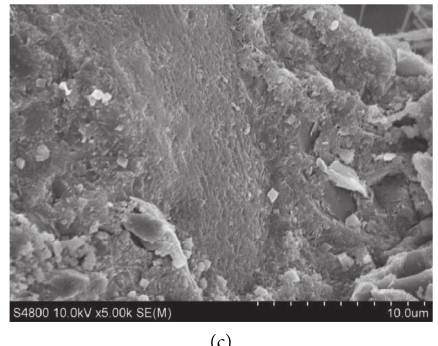
Figure 6: SEM of HPC with different mineral admixtures. (a) Fly ash; (b) CFBC ash; (c) CFBC slag.